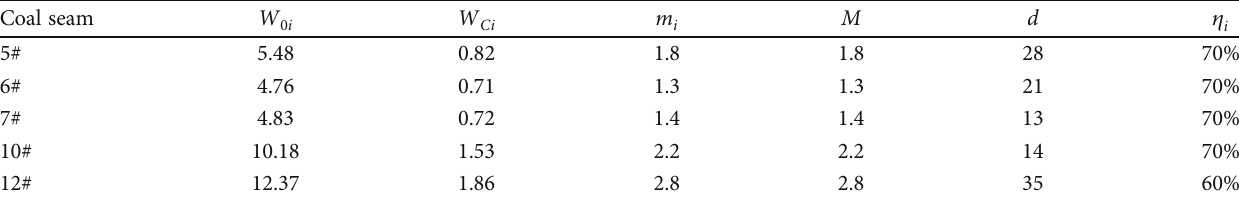
Figure 5: Composition of gas source in working face. Table 2: Relevant parameters for calculating gas emission in adjacent